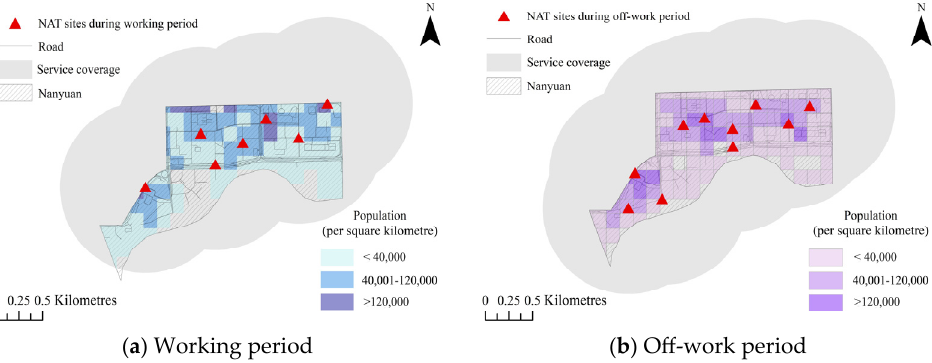
Figure 8. Service coverage of Nanyuan subdistrict.